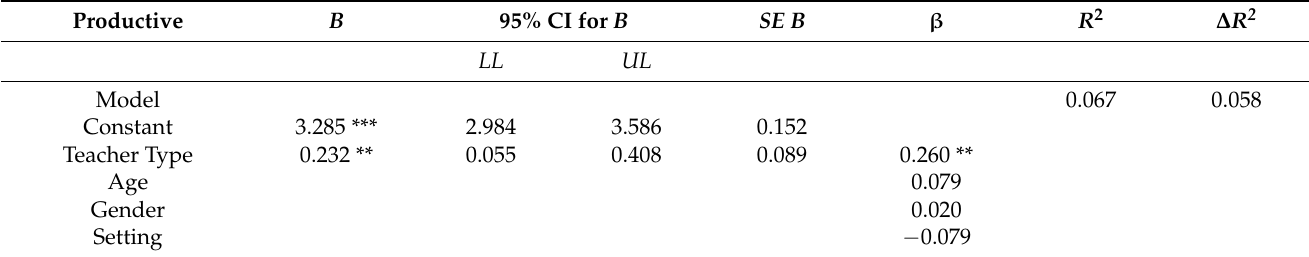
Table 4. Multiple regression results for reproductive (preservice and in-service